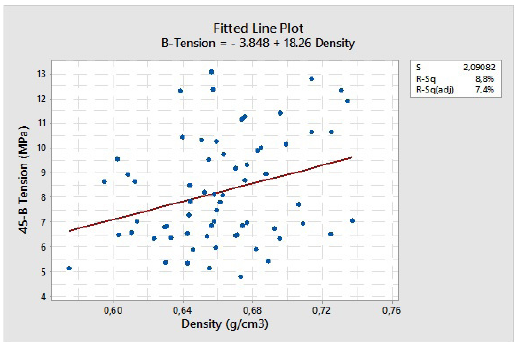
Figure 16. Plotting of the results for the 45-B Orientation Tension Strength and